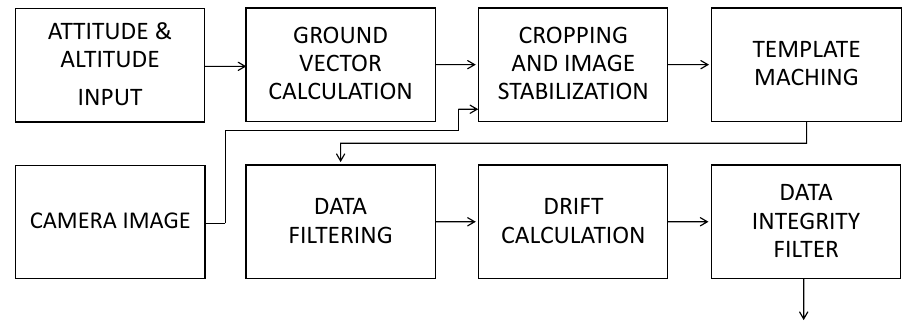
Figure 4. Flow chart of the